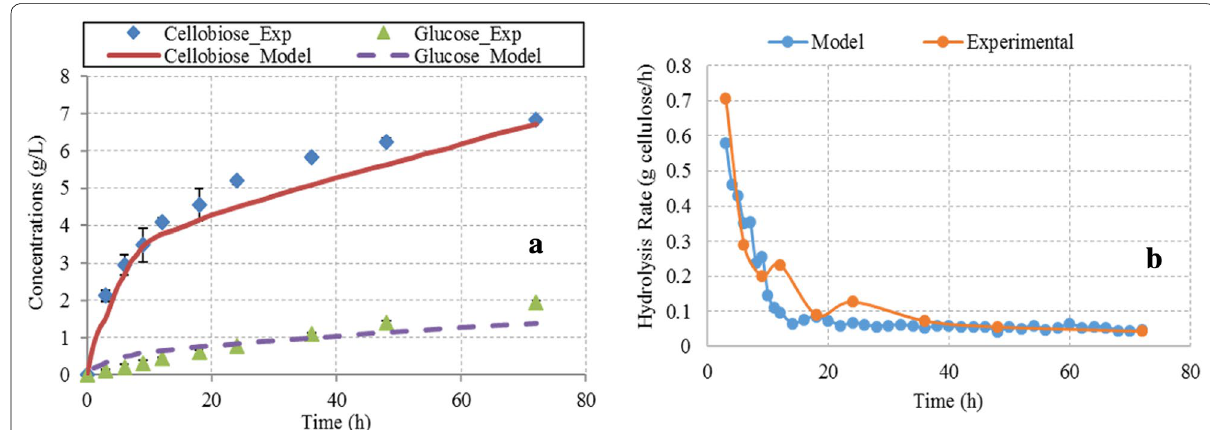
Fig. 8 Comparison of model simulations (solid lines) with experimental data during hydrolysis of filter paper (25 g/L) at CBH I loading of 10 mg/g cellulose: a sugar production, b rate of conversion of cellulose